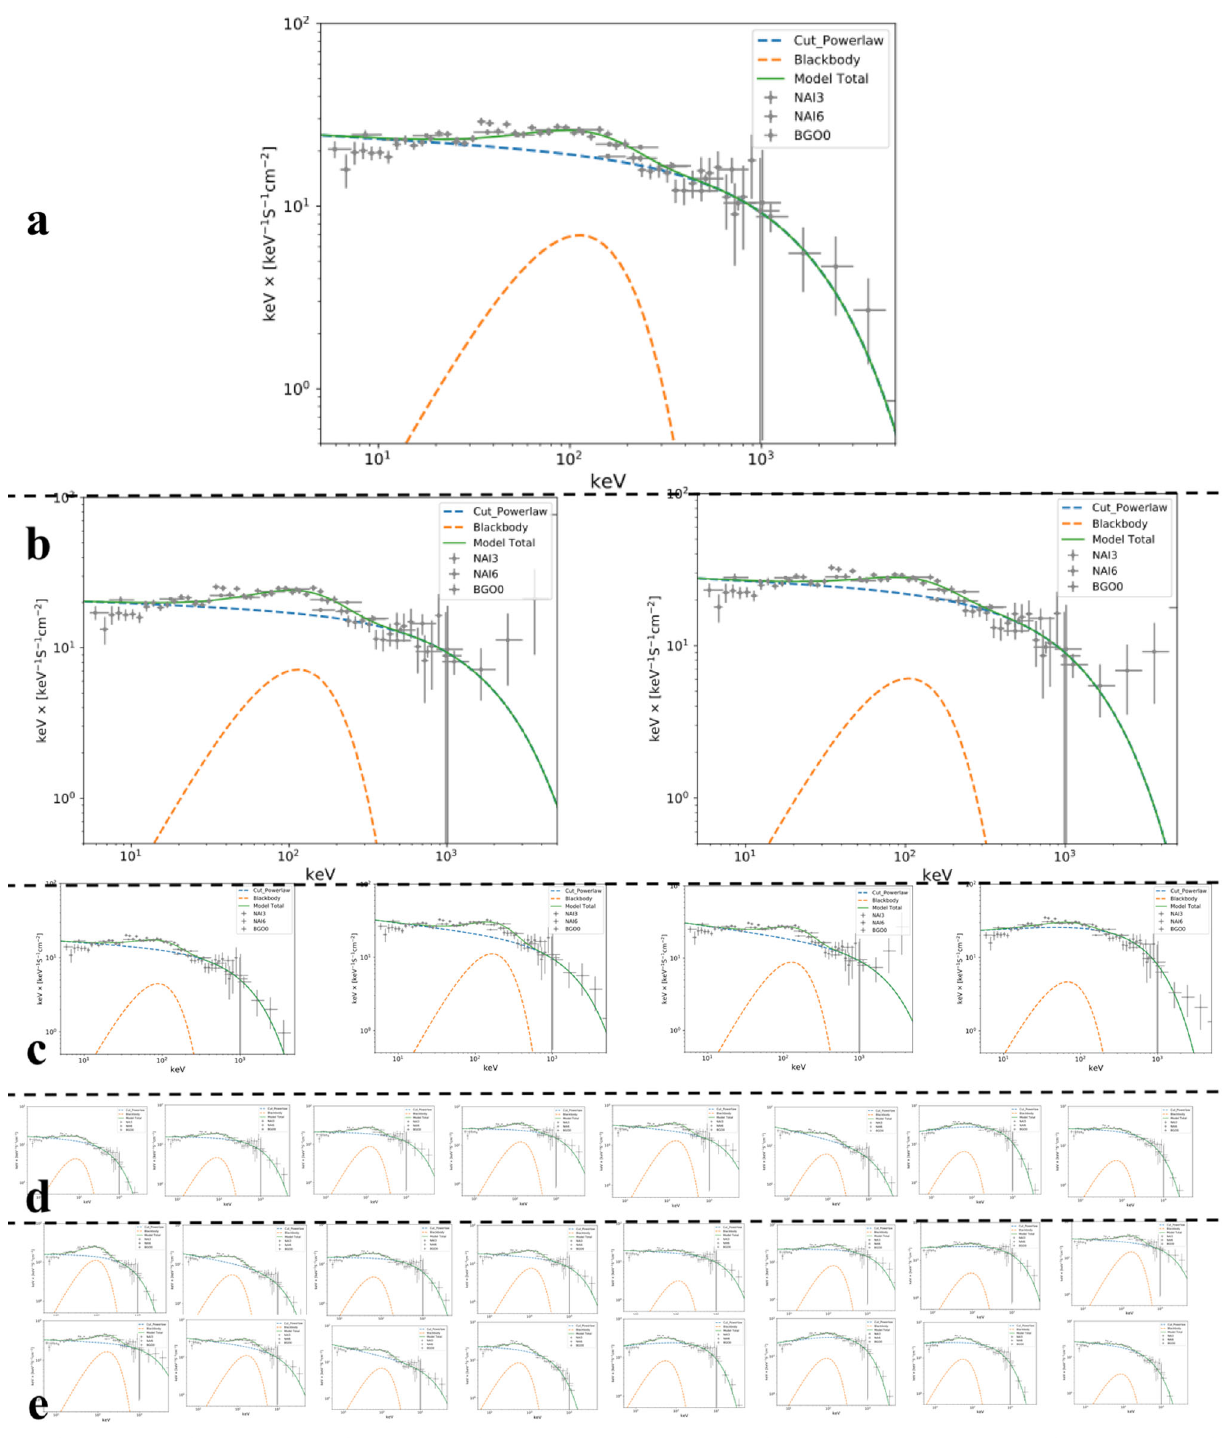
Fig. 4 Time-resolved spectral analysis of UPE II phase of GRB 180720B. a The first iteration: spectrum of the entire UPE II phase extended from t rf = 9 . 07 s to t rf = 10 . 89 s. b The second itera- tion: spectral analysis carried out over two equal rest-frame time inter- vals of [9 . 07s–9 . 98s] and [9 . 98s–10 . 89s]. c The third iteration: spec- tral analysis performed over four equal rest-frame time intervals of [9 . 07s–9 . 53s], [9 . 53s–9 . 98s], [9 . 98s–10 . 44s] and [10 . 44s–10 . 89s]. d The fourth iteration: spectral analysis performed over eighth equal rest- frame time intervals of [9 . 07s–9 . 30s], [9 . 30s–9 . 53s], [9 . 53s–9 . 75s],